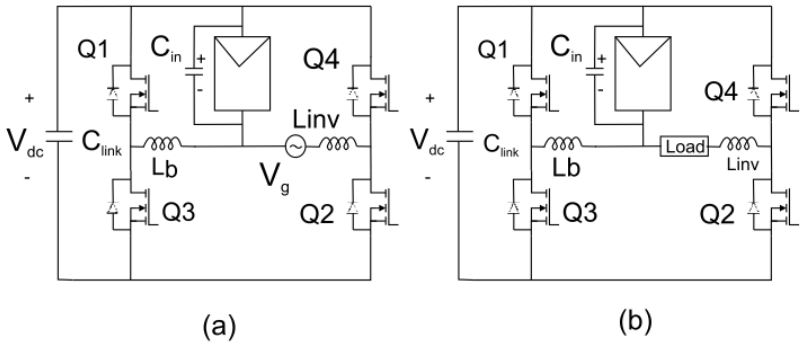
Figure 11. Doubly grounded inverter topology proposed in [84]: ( a ) PV connected to the grid. ( b ) PV connected to the load.